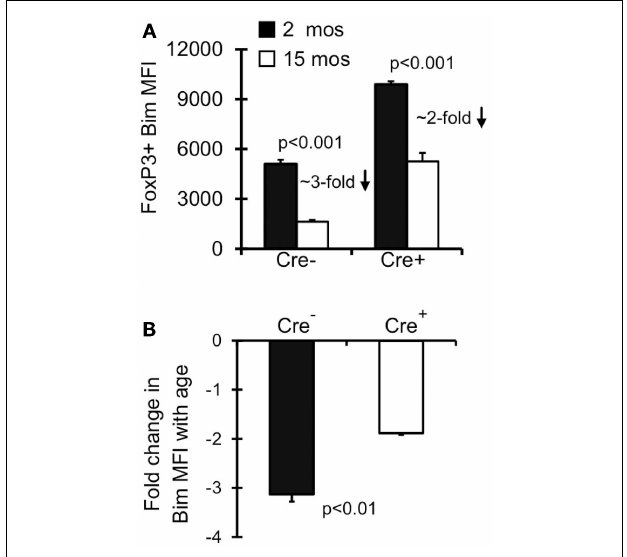
FIGURE 3 | Both environment and survival contribute to the emergence of Bim lo T reg . Splenocytes from Lck-Cre − Bax f/f Bak − / − ( n = 3–5/group) and Lck-Cre + Bax f/f Bak − / − ( n = 3–5/group) mice were stained for CD4, FoxP3, and Bim and analyzed by flow. (A) Results show the Bim MFI in CD4 + FoxP3 + cells ( ± SE).The p values represent the difference between 2 month-old and 15 month-old mice (Student’s t test). (B) Results show the fold change in CD4 + FoxP3 + Bim expression in 15month Lck-Cre − Bax f/f Bak − / − and Lck-Cre + Baxf /f Bak − / − mice compared to their 2month counterparts.The p values represent the difference between Lck-Cre − and Lck-Cre + (Student’s t